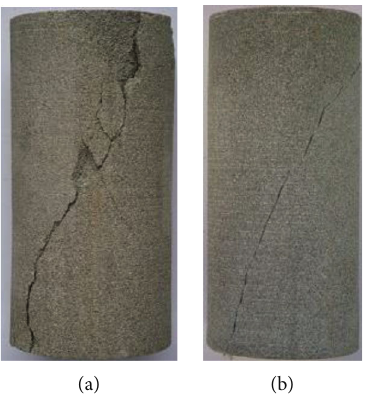
Figure 4: Uniaxial (triaxial) compression failure